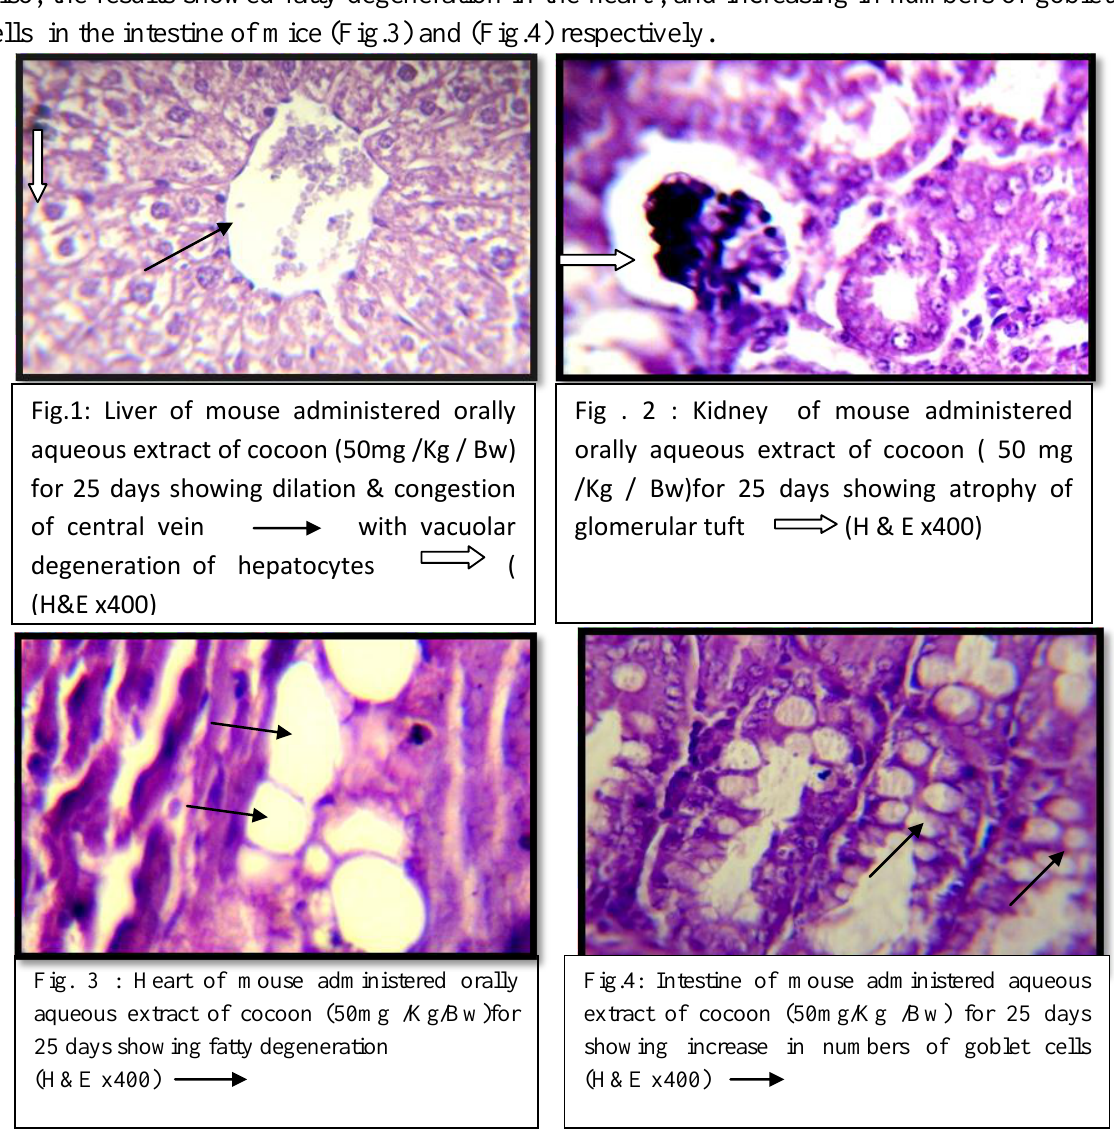
Fig. 3 : Heart of mouse administered orally aqueous extract of cocoon (50mg /Kg/Bw)for 25 days showing fatty degeneration (H&E x400)